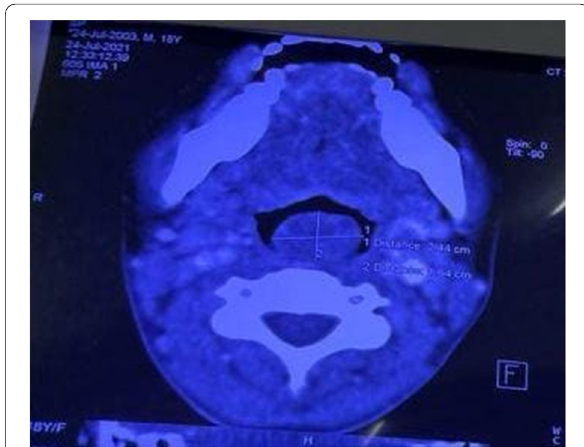
Fig. 1 CECT neck (Coronal cut) showing mass arising from left tonsillar fossa with necrosis